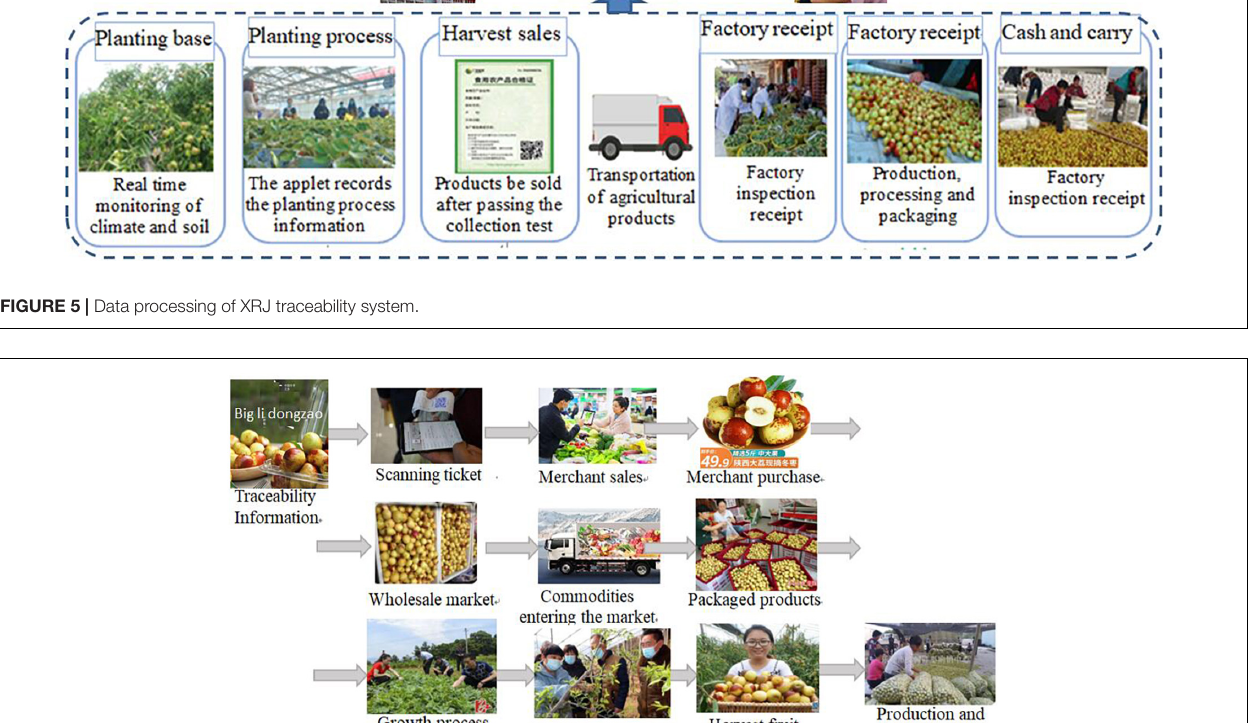
FIGURE 6 | Implementation processing of XRJ traceability